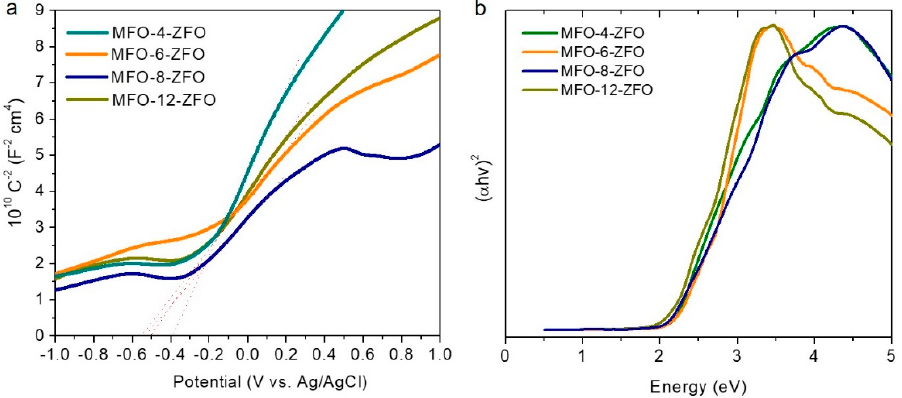
Figure 4. ( a ) Mott-Schottky and ( b ) Tauc plots of the dual component MFO-ZFO MNAs catalysts. In panel ( a ), the red lines show the E FB potential of the semiconductors. Table 2. Optical and electrochemical data (pH = 7) for ZFO, MFO, and MFO-ZFO MNAs.